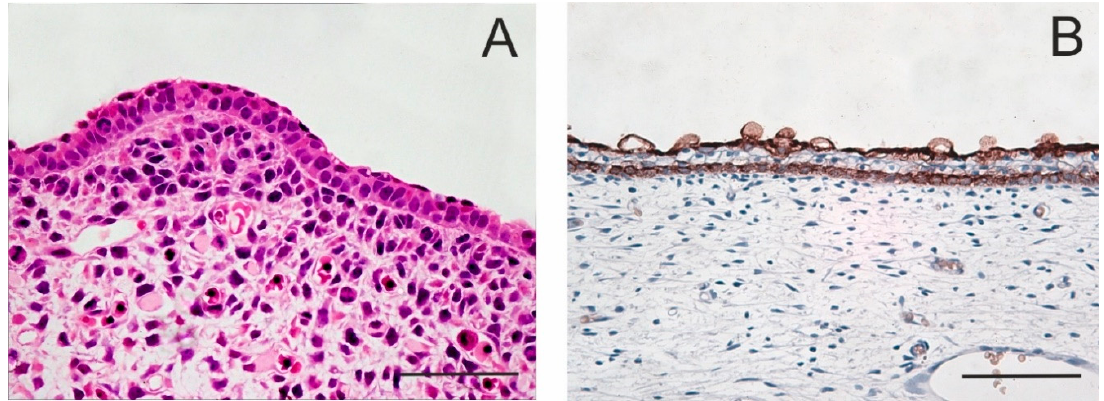
Figure 1. Periderm in embryonic epidermis. The periderm forms the outermost layer of embryonic skin that looks like a single superficial layer of flattened cells which functions as a permeability barrier. E12 mouse; staining with haematoxylin–eosin ( A ). After the appearance of an intermediate cell layer, the periderm becomes separated from the basal layer. Skin of a 14-week human embryo; anti-keratin 19 immunoperoxidase staining ( B ). Scale bar 50 μ m.